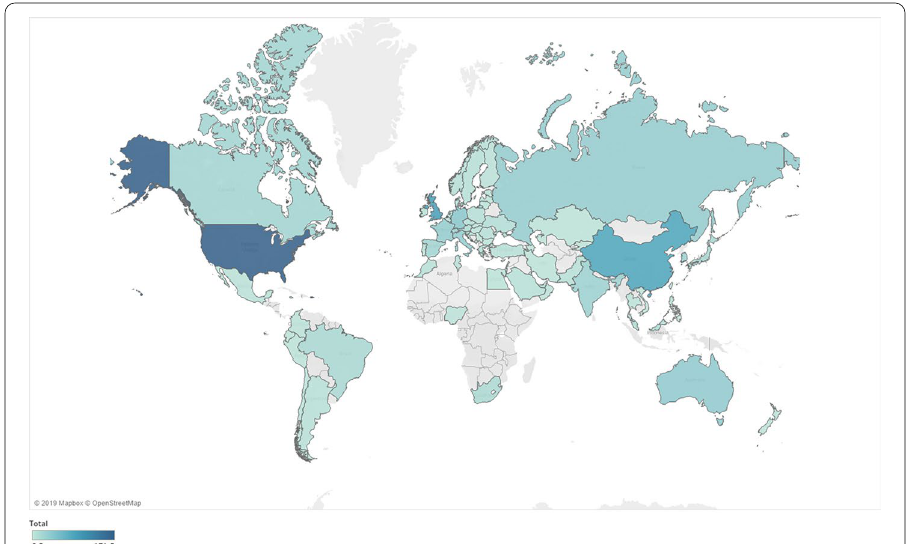
Fig. 4 Geographical distribution. Mercator projection Map. Landmasses appear larger the farther they are from the poles. The projection, however, maintains constant bearings for navigation. Source : Own